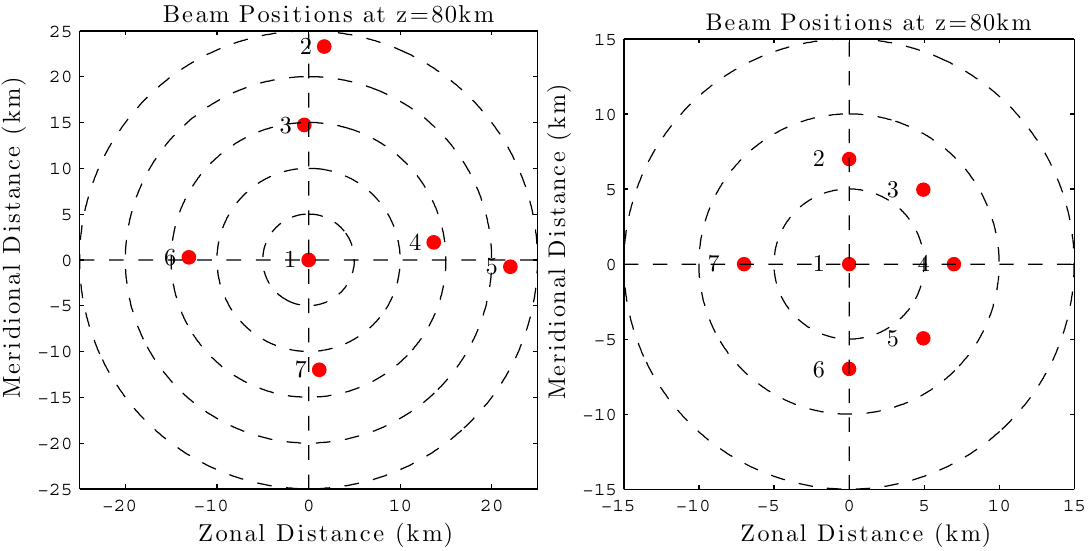
Fig. 1. PFISR beam position maps used in this paper, each with 7 look directions and evaluated at 80km altitude. Left: A standard experi- mental beam map that has been used in several PFISR experiments. Right: A theoretical beam map with smaller off-zenith angles. Azimuth and elevation angles are listed in Table